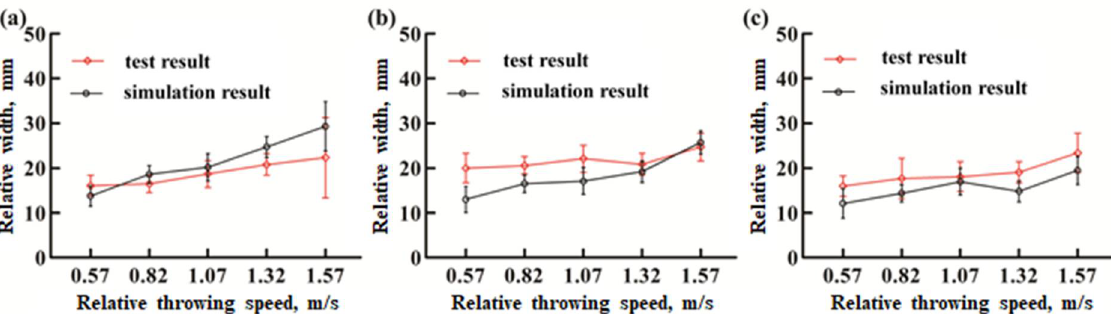
Figure 21. The relationship between relative width and relative seed throwing speed for ( a ) SN42, ( b ) JD17 and ( c ) ZD39.